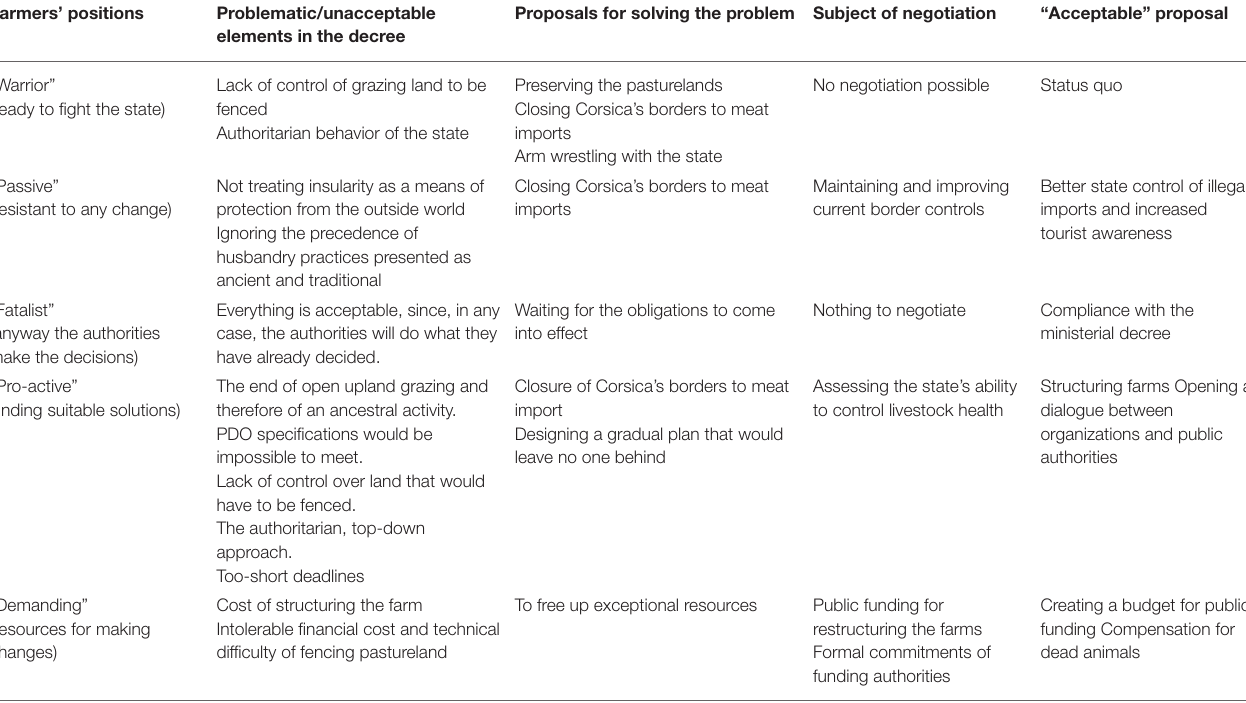
TABLE 2 | Farmers’ positions at the first two meetings of the pig farmers’ collective mobilized against the French national biosecurity measures to fight African swine fever. Farmers’ positions